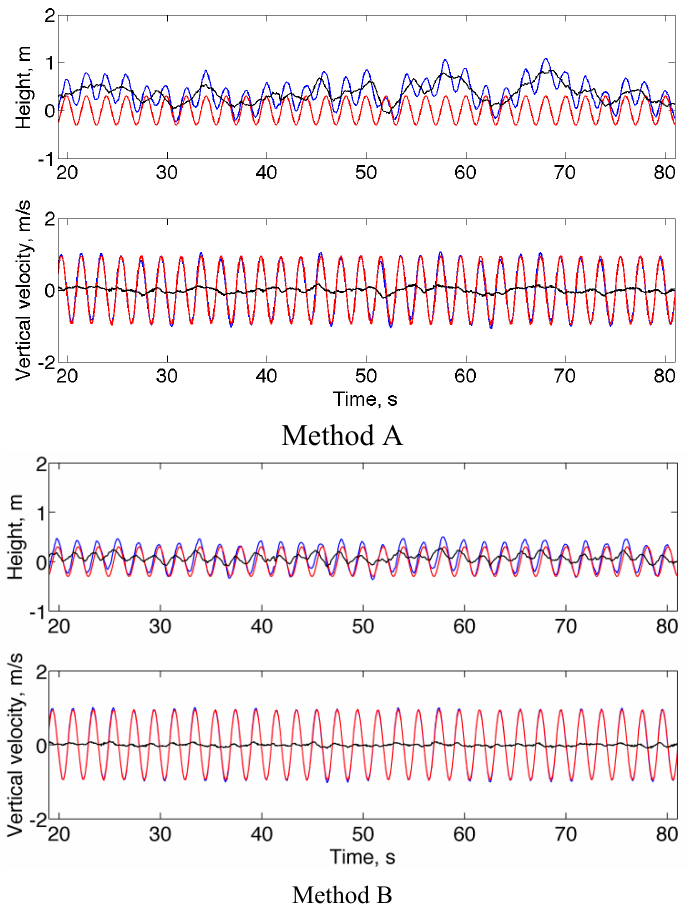
Figure 5. Forced circular motion. Estimated (blue) and reference (red) height and vertical velocity time functions, with superimposed the difference error between estimated and reference time functions (black). Data are displayed in the time interval from 20 to 80 s for improved graphical